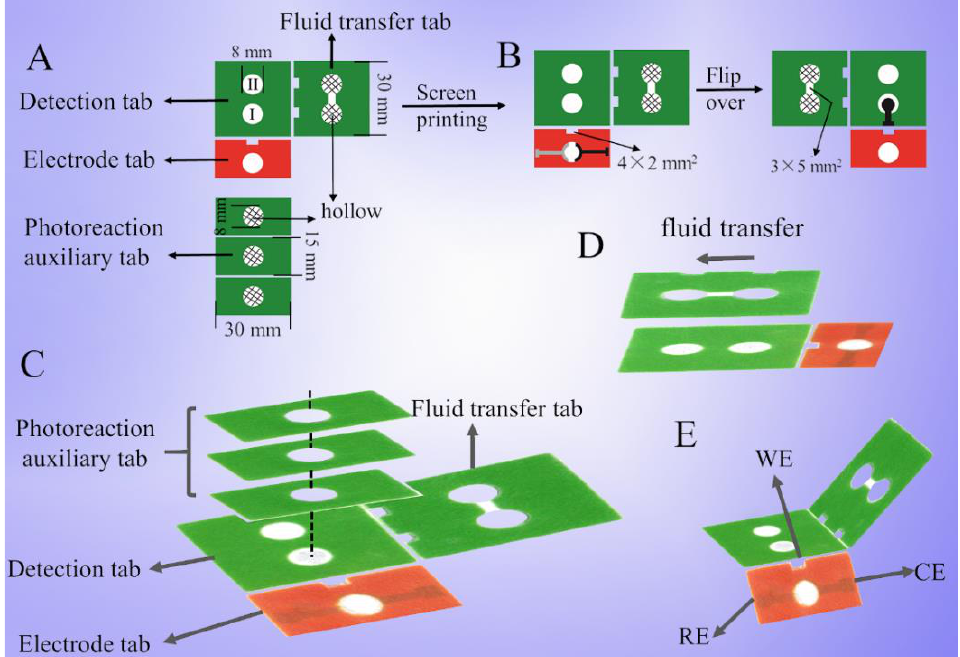
Figure 1. Schematic layout of ( A ) prepared device and ( B ) the fabricated device with screen − printed electrodes. Assembly illustration of prepared device during ( C ) photoreaction, ( D ) fluid transfer, and ( E ) sensing platform.